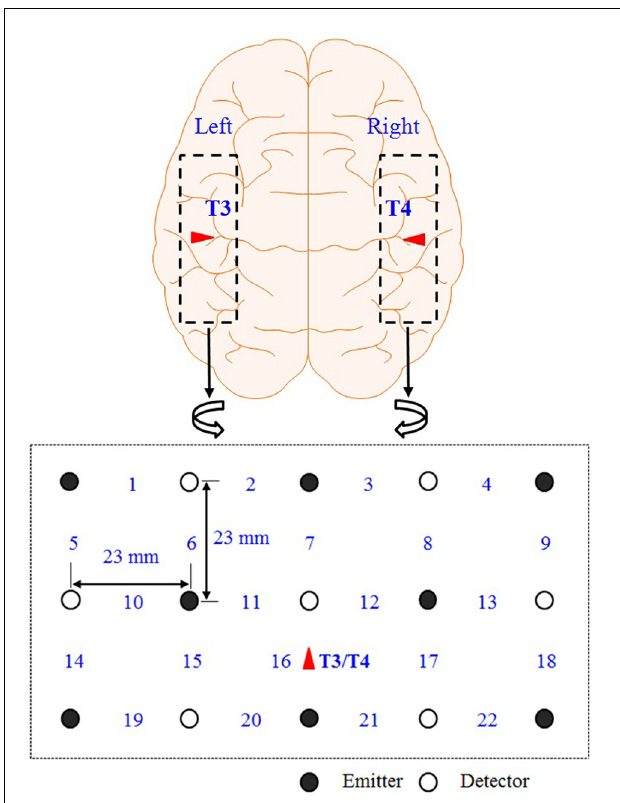
FIGURE 2 | Optodes configuration. Numbers represent the measurement channels: The channel number 16 coincides with the T3/T4 locations in the International 10–20 System.